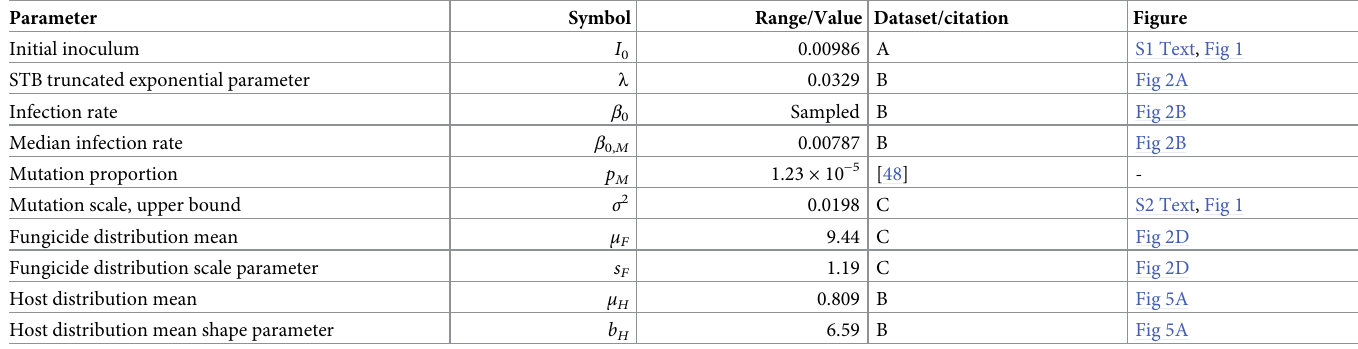
Table 4. Parameter values used in the model (to 3 significant figures). The parameter values were found in the model fitting process using the data described in Table 3. The sampled infection rates are generated from a truncated exponential distribution with maximum 100 and parameter λ (see Eq 23). Parameter Symbol Range/Value